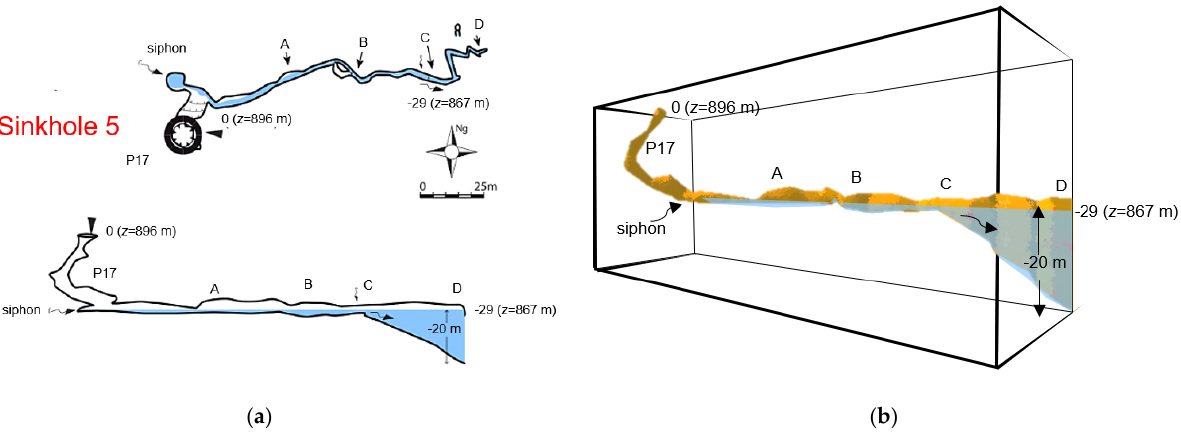
Figure 12. Sinkhole No.5: ( a ) plan; ( b ) three-dimensional layout.